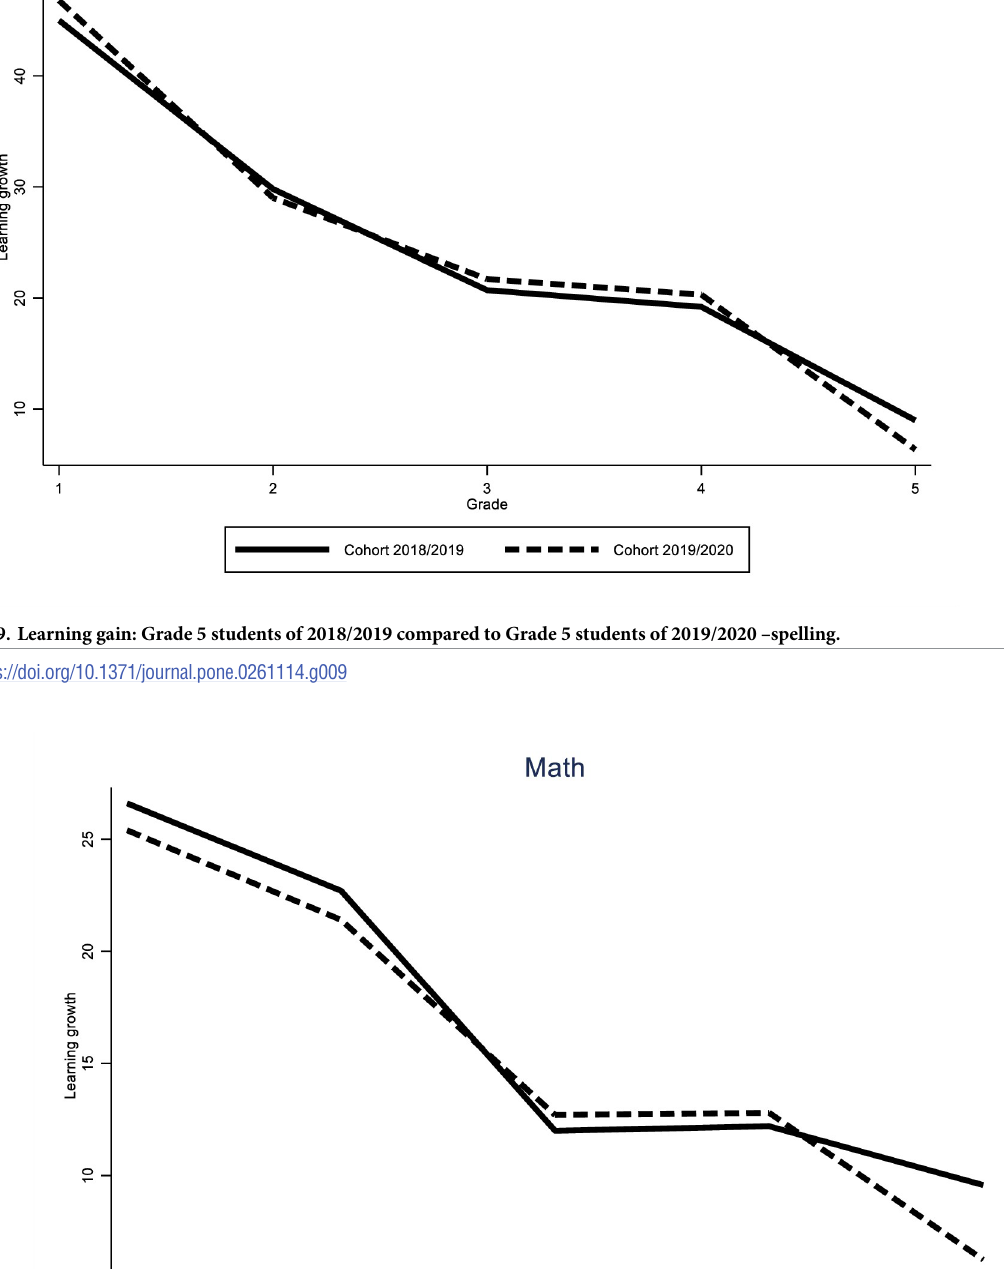
PLOS ONE | https://doi.org/10.1371/journal.pone.0261114 February 2,